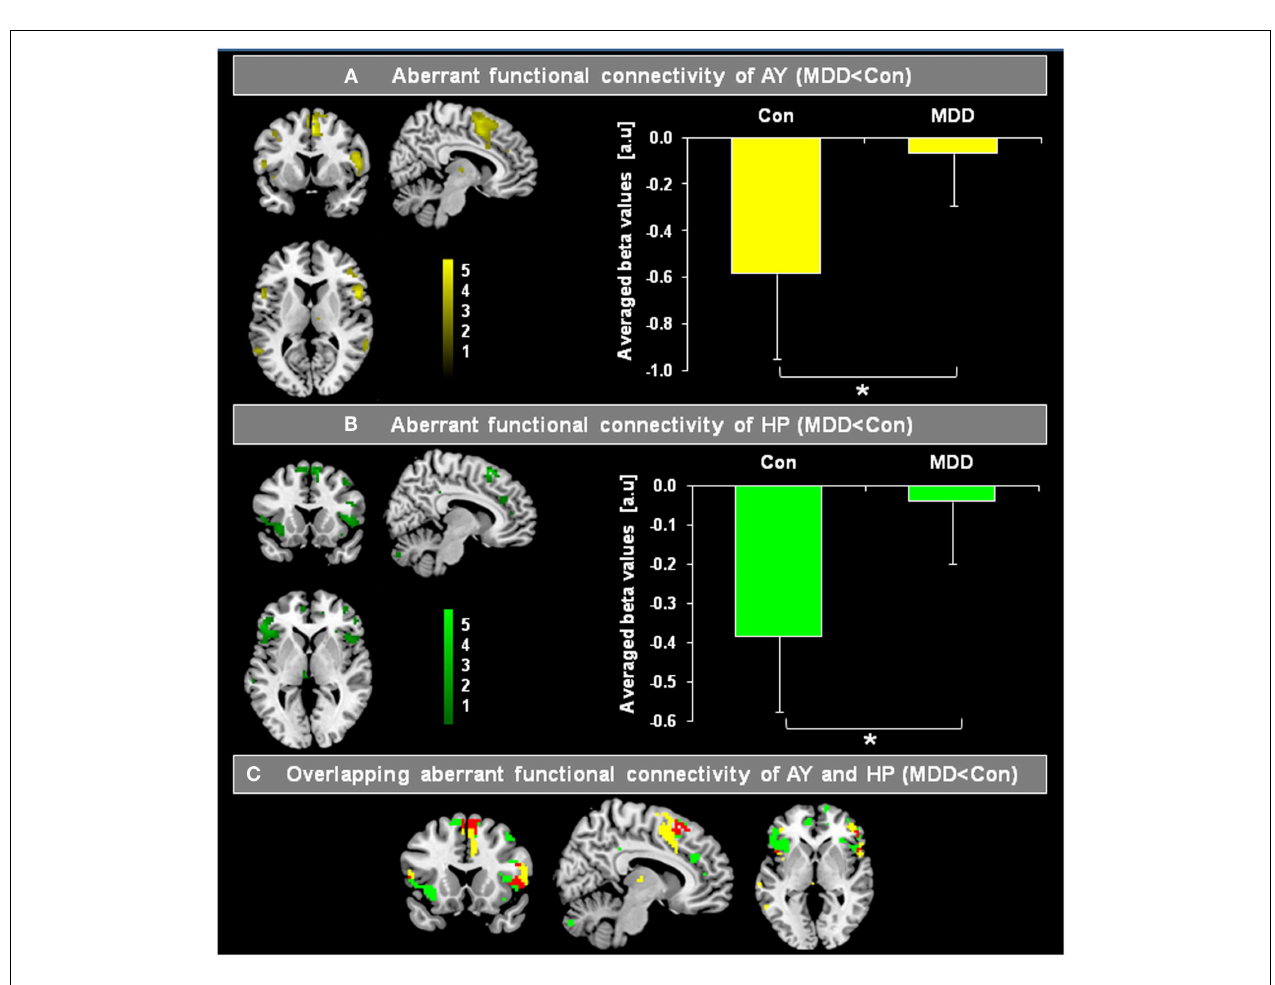
on a single-subject’s high resolutionT1 image, and represent the main effect of group on the FC of the AY and HP, respectively ( p < 0.05, FDR corrected; bars represent range of t -values). Bar graphs on the right side reflect averaged iFC of AY and HP for MDD patients and healthy controls, respectively (two-sample t -tests, p < 0.05). In (C) , regions of overlapping reduced FC of AY (A) and HP (B) are shown in red.The HP and AY have reduced FC in the dorsomedial-prefrontal cortex and fronto-insular operculum in